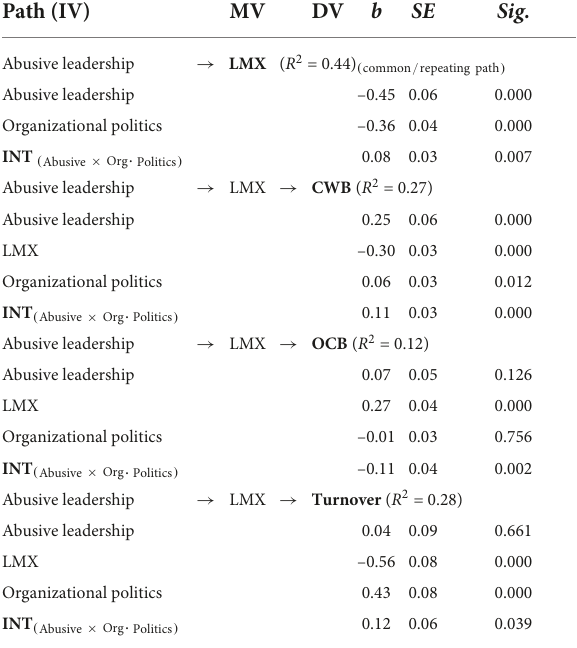
TABLE 2 Moderated-mediation results (perception of organizational politics [POP] as the moderator).